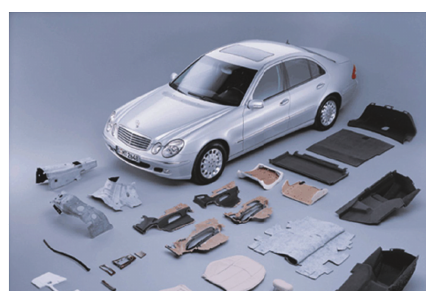
Figure6:Automobilecomponentsmadeofnaturalfibercomposites [36].